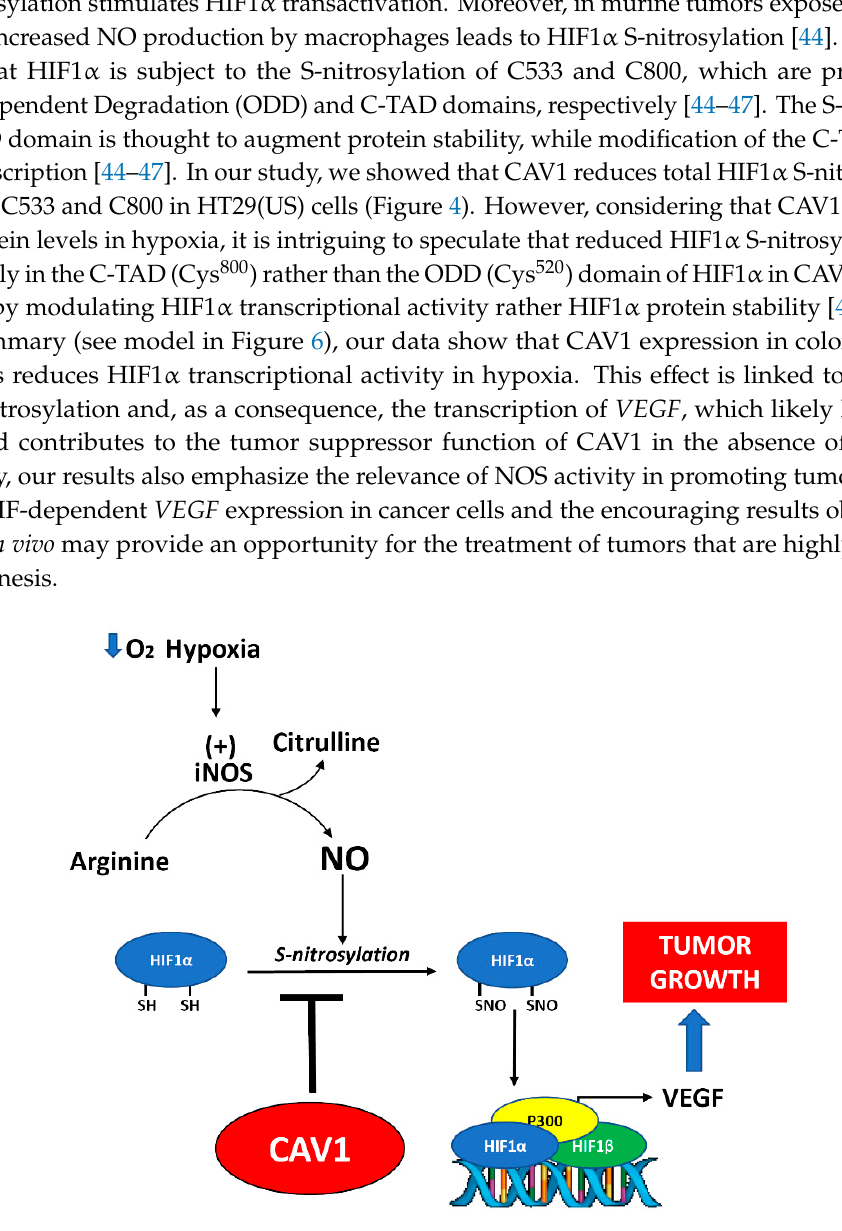
Figure 6. Working model summarizing the main findings in this study. CAV1 acts as a tumor suppressor in the absence of E-cadherin. The effect of CAV1 reported here is not mediated by reducing protein stability or nuclear translocation, but rather by the S-nitrosylation of HIF1 α . Based on our main findings, we propose that HIF1 α S-nitrosylation induced by hypoxia is inhibited by CAV1, preventing VEGF induction, thereby providing a rationale for E-cadherin-independent tumor suppression by CAV1.